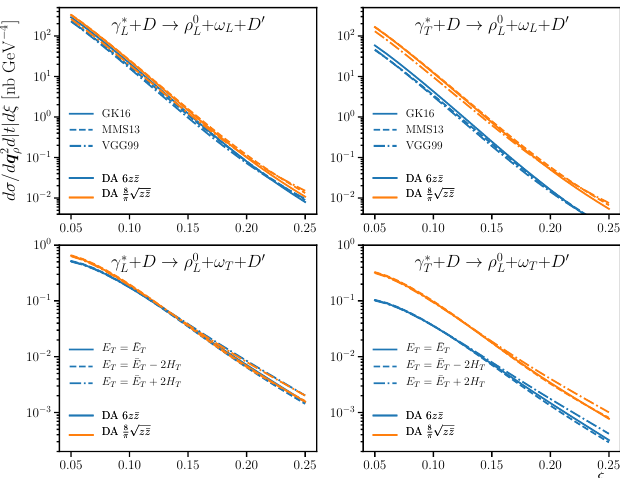
+ ω + D (cid:48) coherent cross section for Figure 3: ξ dependence of the γ ∗ + D → ρ 0 L = 2 GeV 2 . This process is sensitive to the chiral-even deuteron Q 2 = 1 GeV 2 , q 2 ρ GPDs ( ω production, upper row) and chiral-odd deuteron GPDs ( ω production, L T lower row). We compare different GPD and DA models (see [ 1 ] for